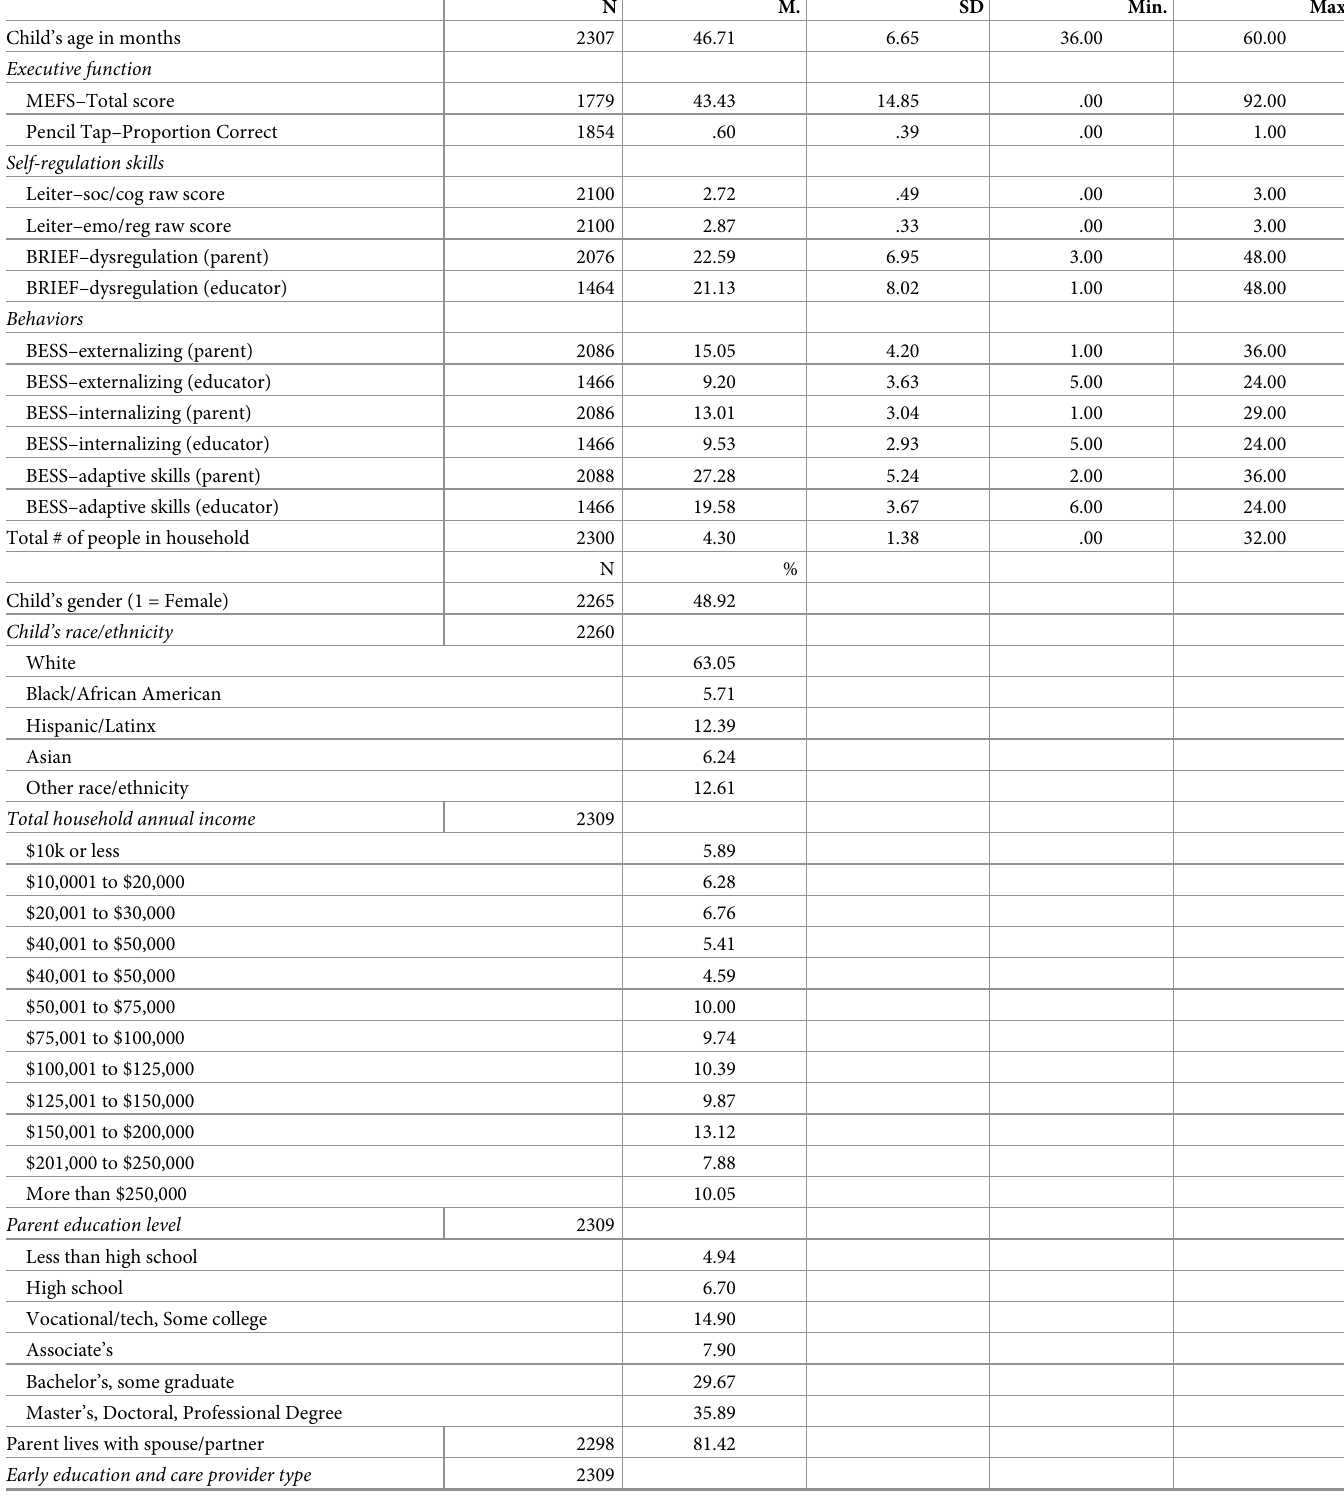
Table 1. Descriptive statistics ( N =